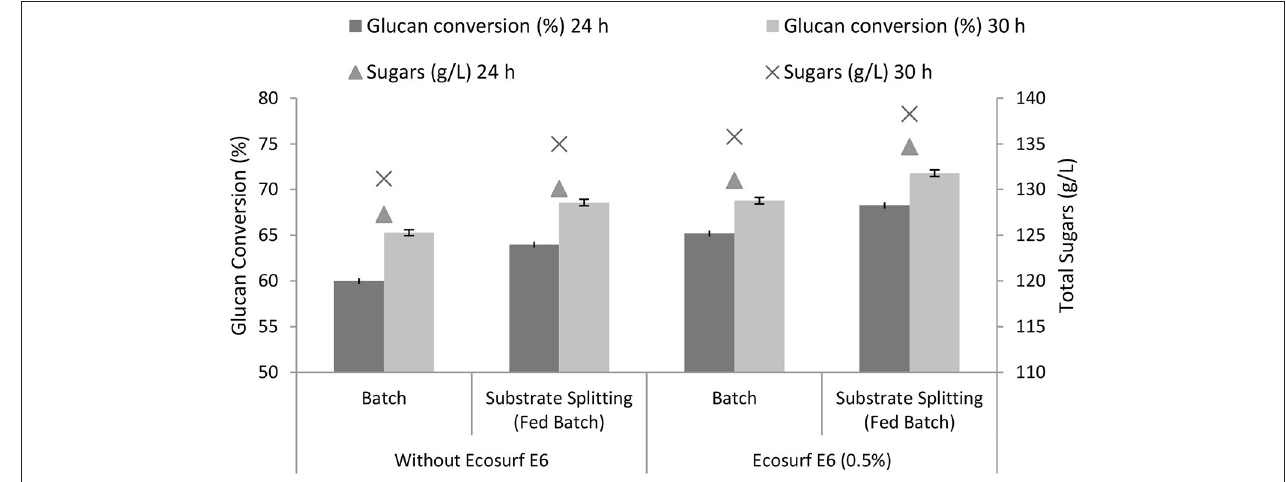
FIGURE 7 | Effect of surfactant (Ecosurf E6) on fed-batch hydrolysis under optimized